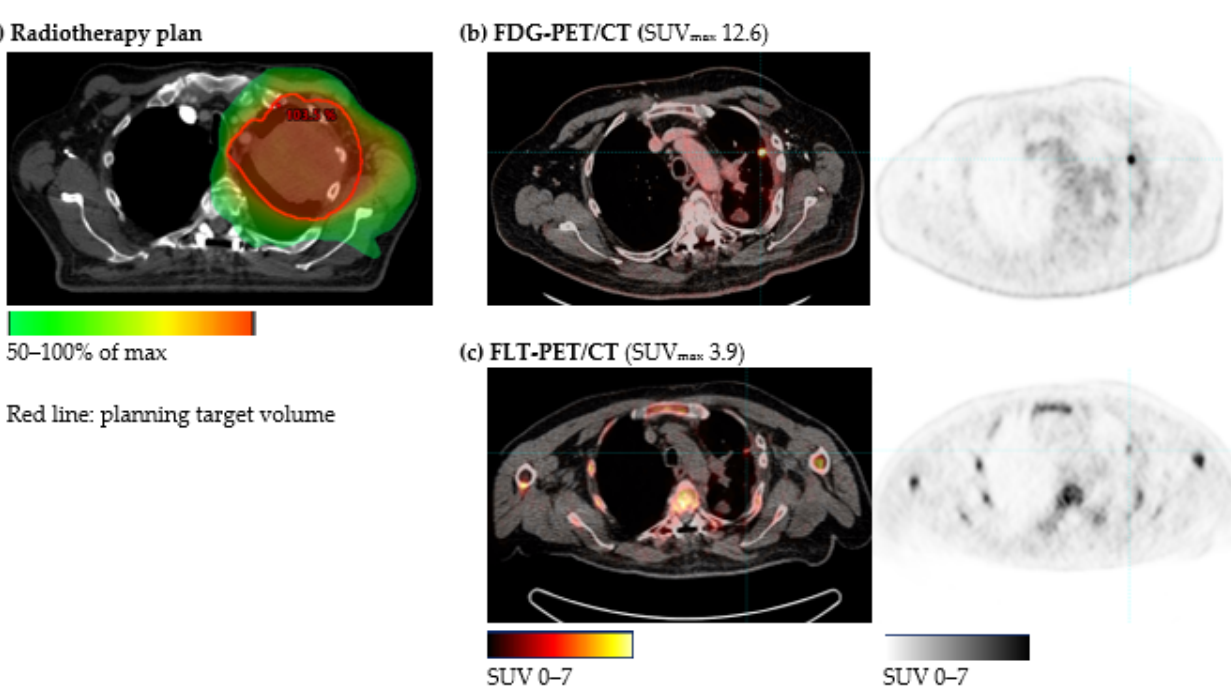
Figure 1. Patient with relapse in the irradiated high-dose volume (HDV). ( a ) HDV defined as the volume irradiated with >50% of max from the radiotherapy plan. The patient received two Gy × 33 for a T3N1M0 tumor in the left upper lobe. FDG-PET/CT ( b ) and FLT-PET/CT ( c ) 7 months after the end of radiotherapy both showed a high tracer uptake. SUV: Standardized uptake value.